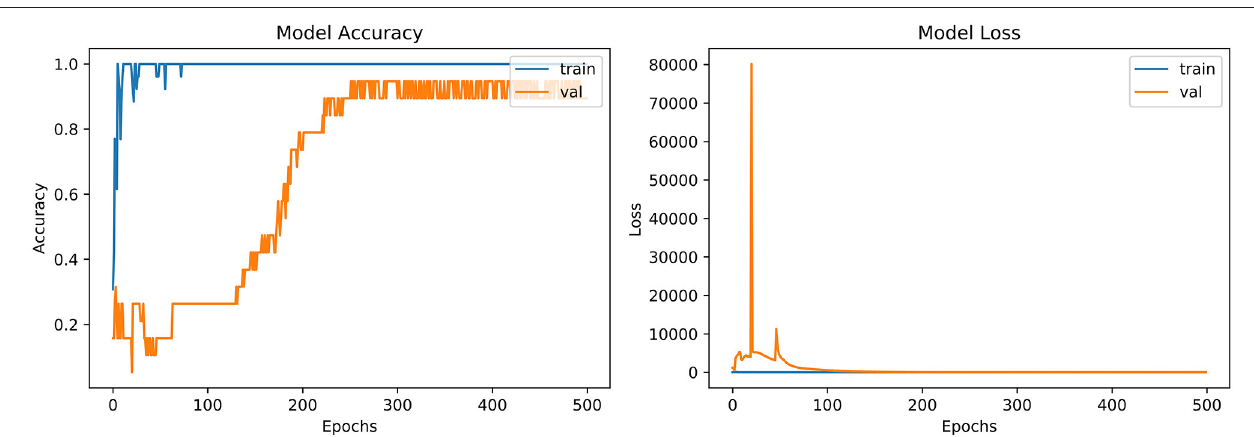
FIGURE 7 | Model accuracy and model loss for ResNet.